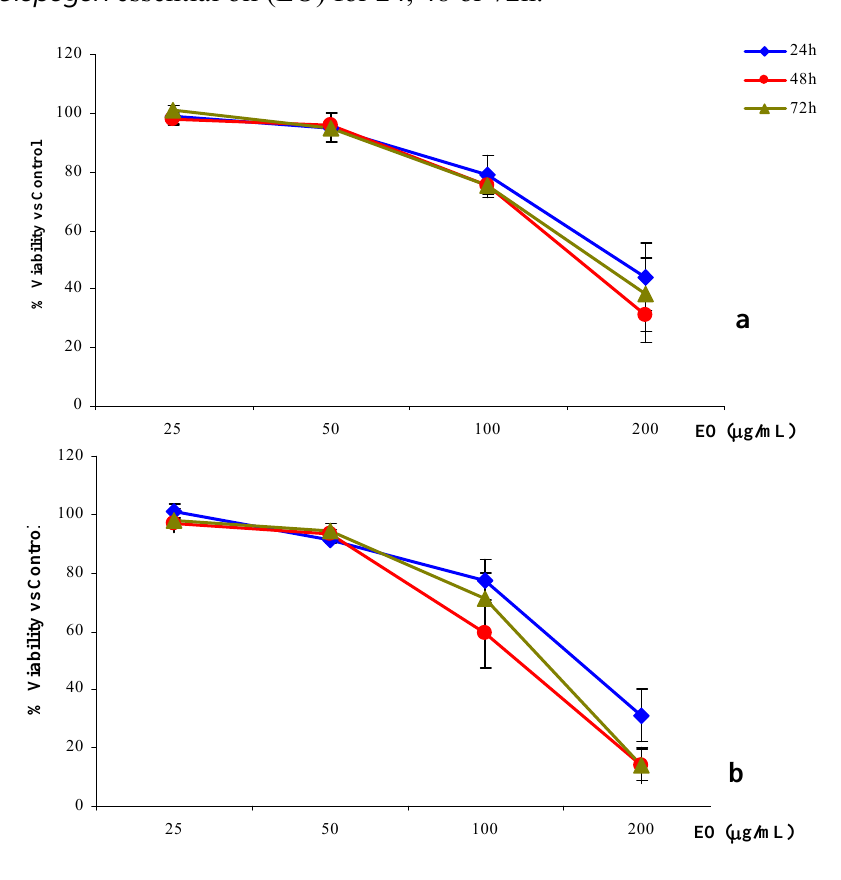
Figure 2. % cell viability versus control of 2008 (a), LoVo (b) and A-431(c) cells treated with R. anthopogon essential oil (EO) for 24, 48 or